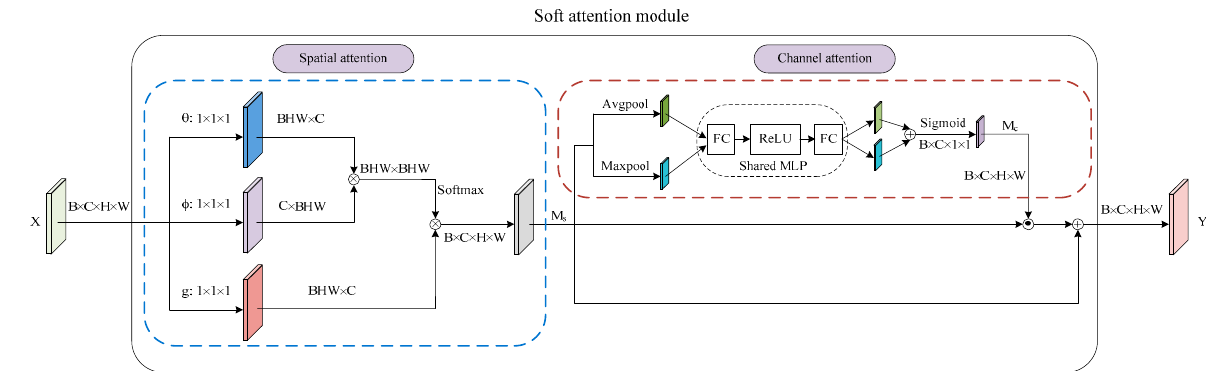
Figure 3. Illustration of soft attention module. We show the arrangement of the spatial and channel attention and more details of these two submodules.